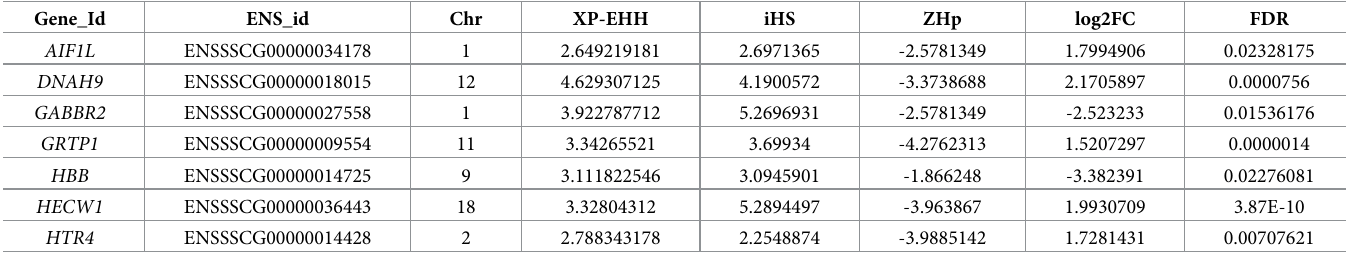
Table 1. Identification of differentially expressed selective sweep